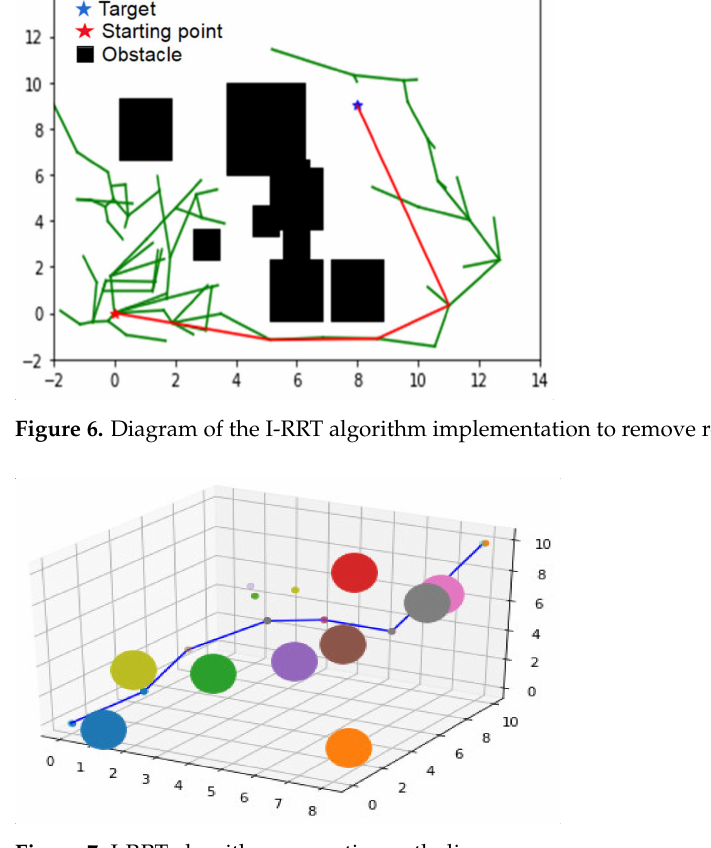
Figure 7. I-RRT algorithm generation path